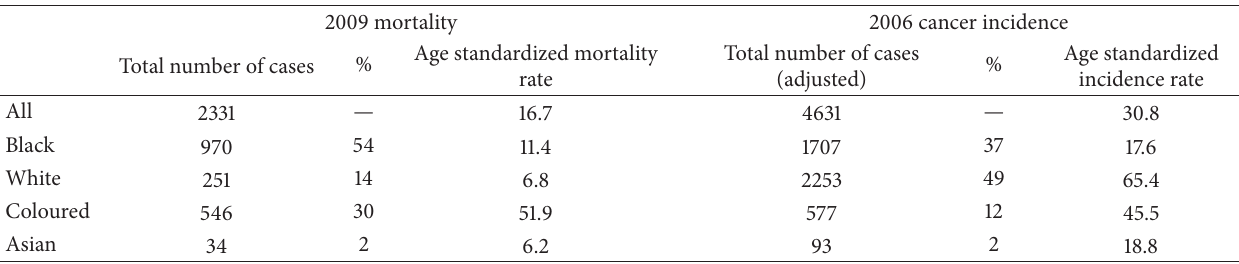
Table 4: Prostate cancer in South Africa, comparison of 2009 mortality data by population group (when population group was known) to 2006 cancer incidence of reported cases to the pathology based National Cancer Registry (latest report